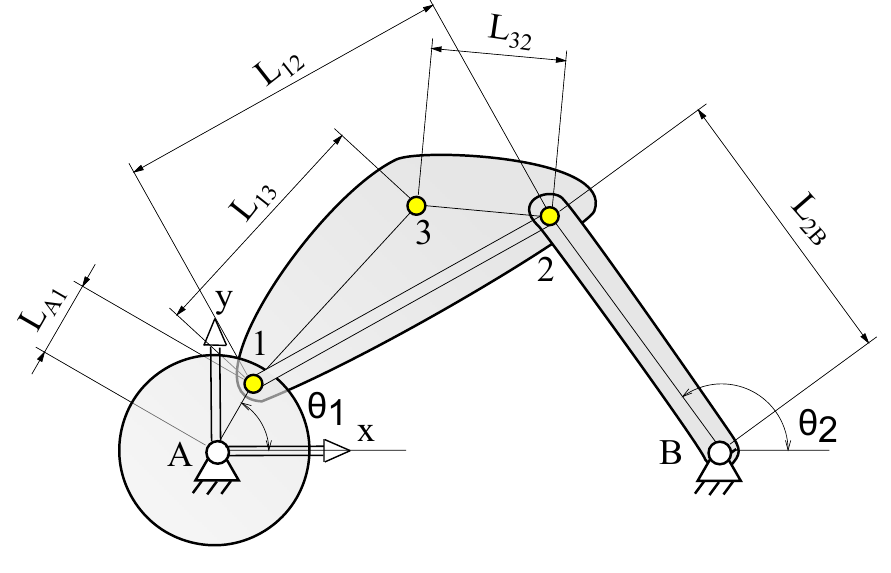
Figure 3. Schematic of the attached